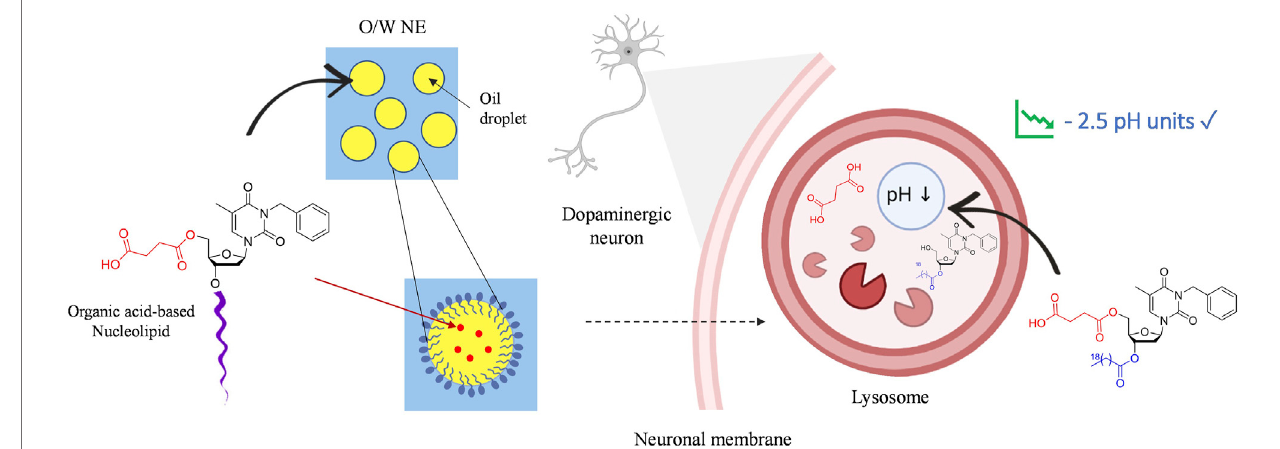
SCHEME 2 | Graphical illustration of neuronal lysosomal acidi fi cation by nucleolipidic nanoemulsions.